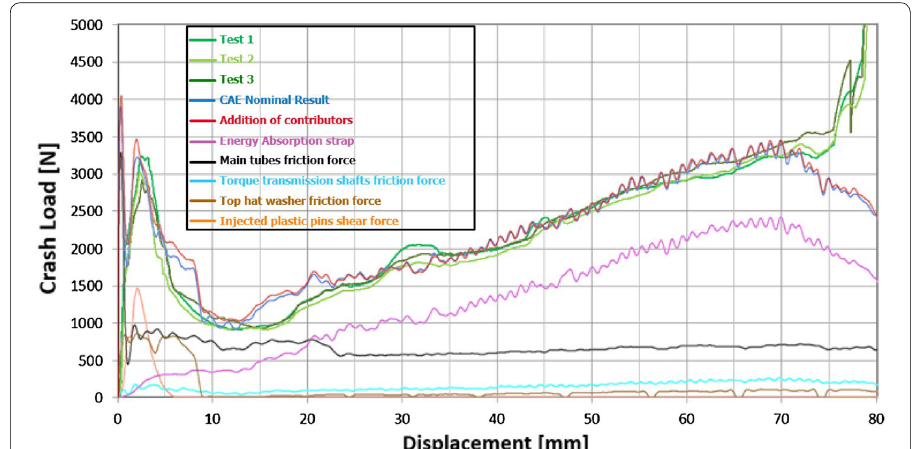
Fig. 10 FEM model correlation and resultant force